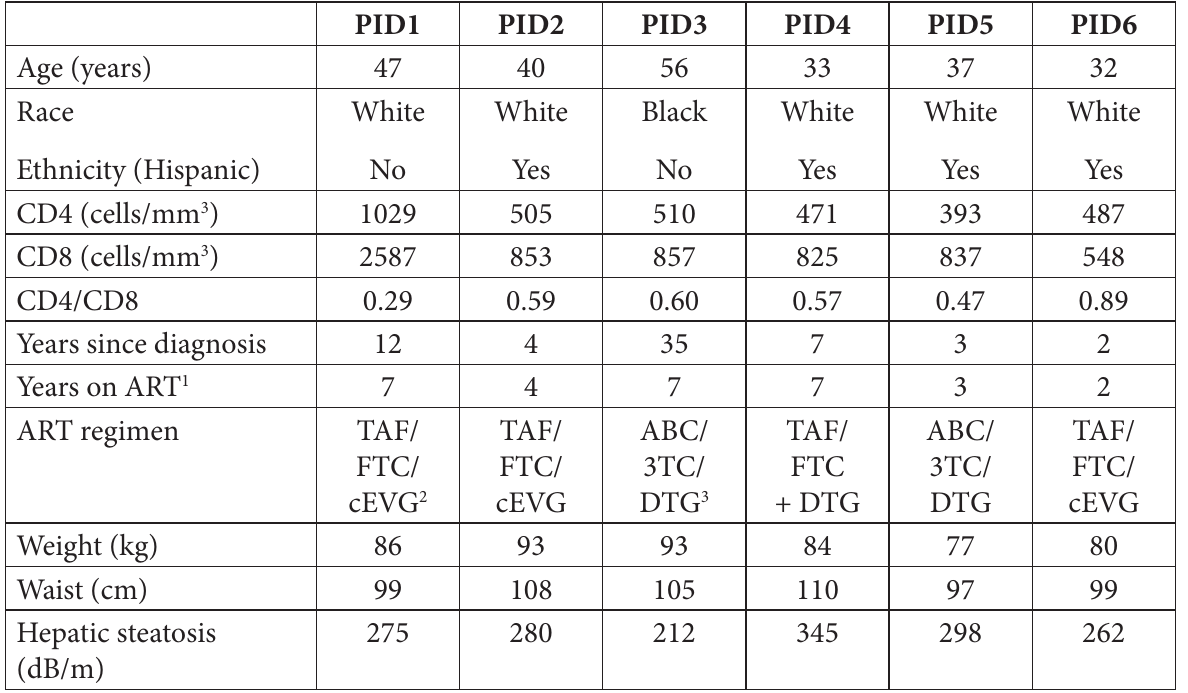
Table 1 . Baseline